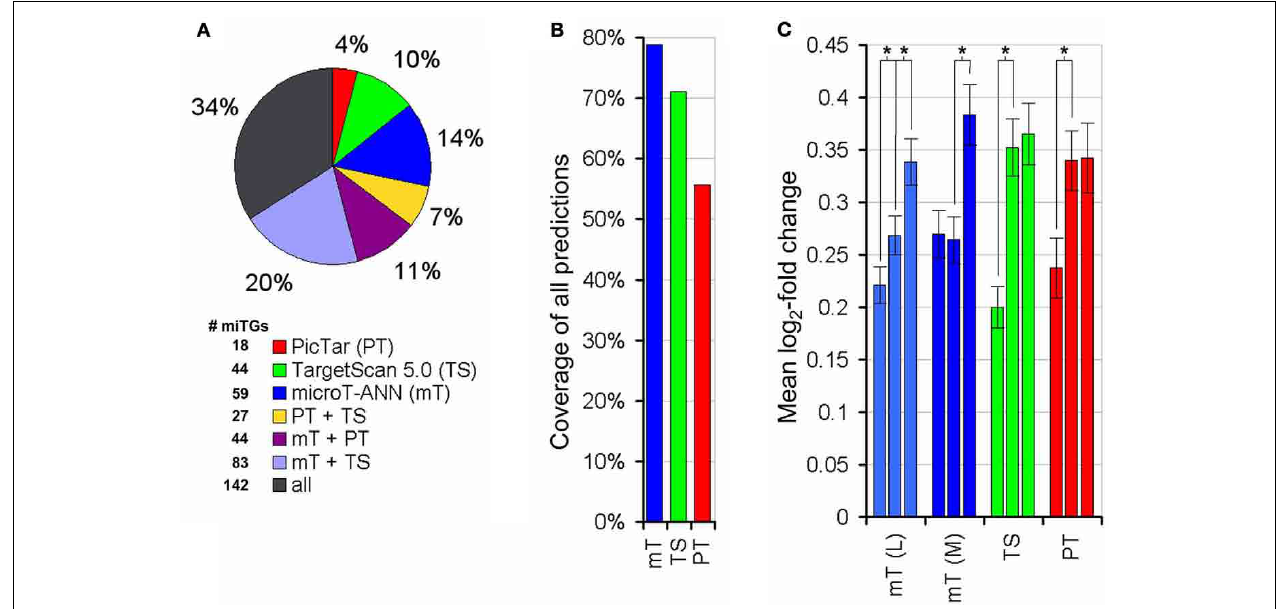
TargetScan 5.0 which miss 35 and 29% respectively. (C) Significance of the prediction scores of DIANA-microT-ANN, PicTar andTargetScan 5.0 in relation to the protein repressions. All predicted targets [mT(L) = DIANA-microT-ANN (loose threshold, 1036 targets), mT(M) = DIANA-microT-ANN (medium threshold, 733 targets),TS = TargetScan5 (612 targets), PT = PicTar (483 targets)] are sorted according to their prediction scores and divided into three equal-sized bins. Significant differences between adjacent groups are indicated (asterisk, P < 0.005, Mann–Whitney U -test).The predictions of DIANA-microT-ANN are the only showing significant differences between the middle and top third, both at loose and medium threshold. For PicTar and TargetScan 5.0 only the lower and middle third of the predictions have significant differences in their protein-fold